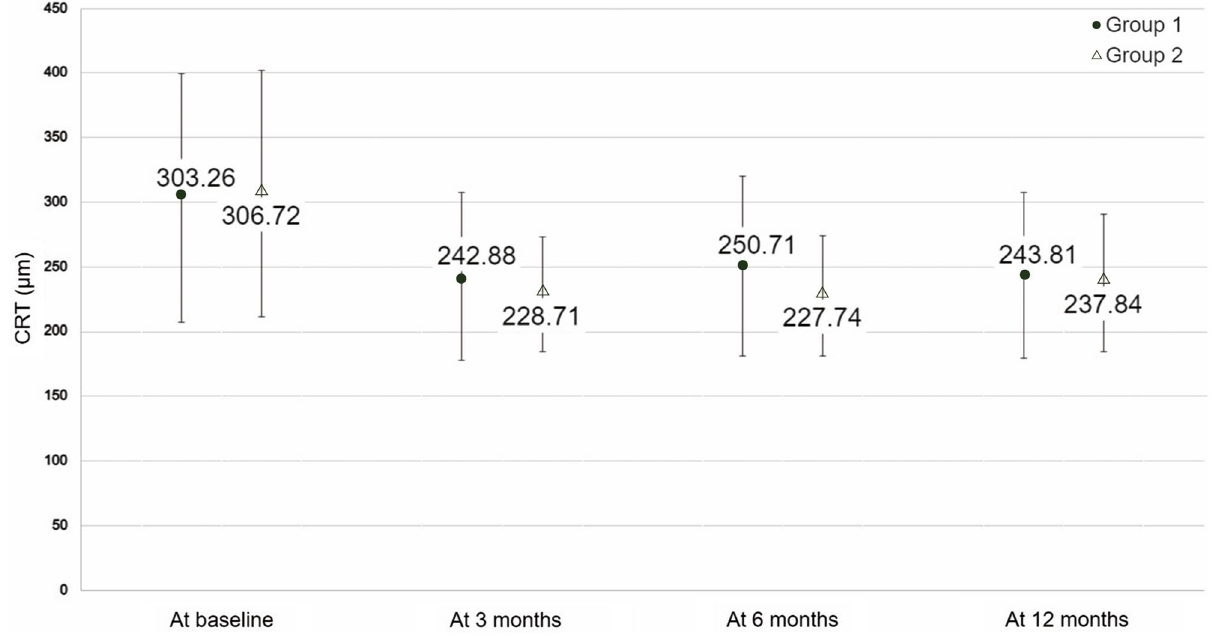
Figure 2. Mean central retinal thickness in the two treatment groups at different timepoints. Group 1 intravitreal injection of ranibizumab + photodynamic therapy, Group 2 intravitreal injection of aflibercept alone, CRT central retinal thickness. Group